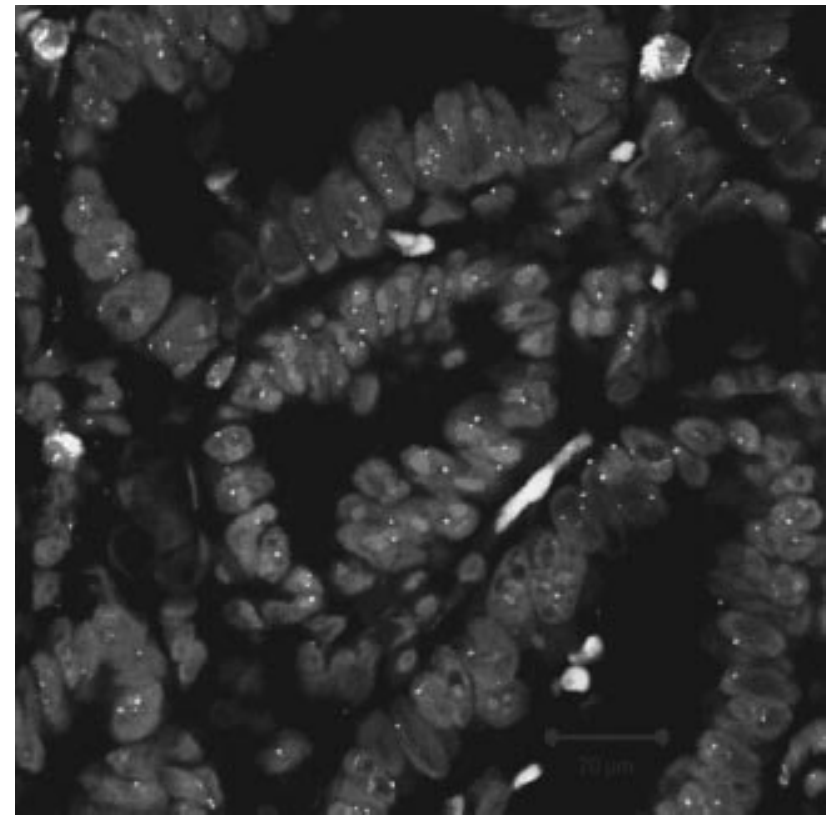
Fig. 3. Heterogeneity of Her-2/ neu gene amplification in BCA of case #4 shown by dual-colour FISH with Her-2/ neu -specific probes (red signals) and chromosome 17 centromeric probes (green signals) counterstained with TO-PRO TM -3 iodide. Note that the tumour cells in the centre of the BCA area show high-level Her-2/ neu amplification (clusters), while the remaining tumour cells show no, or only low-level, Her-2/ neu